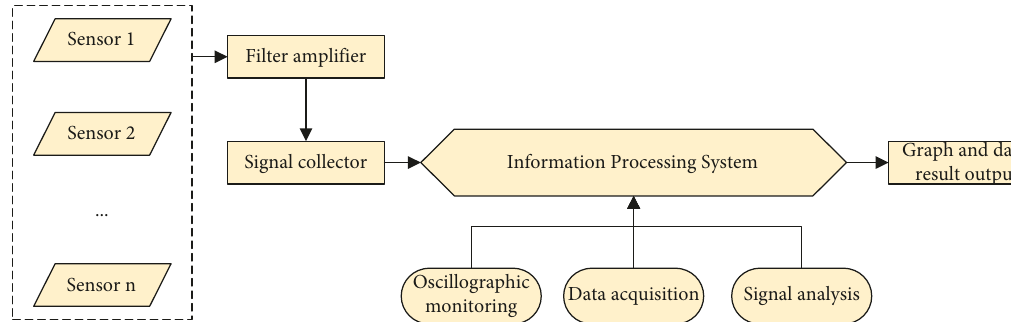
Figure 5: Architecture of data acquisition and processing system.